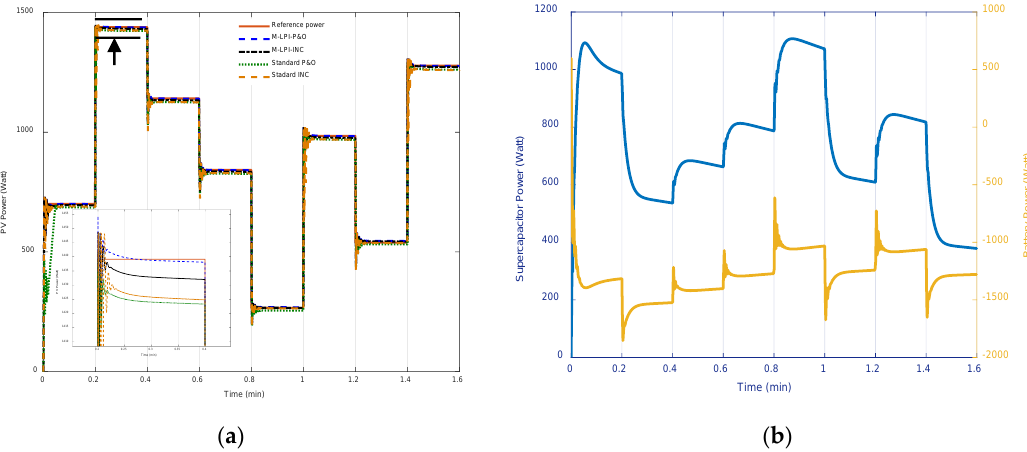
Figure 14. Generated power, ( a ) photovoltaic module, ( b ) Supercapacitor and Battery.